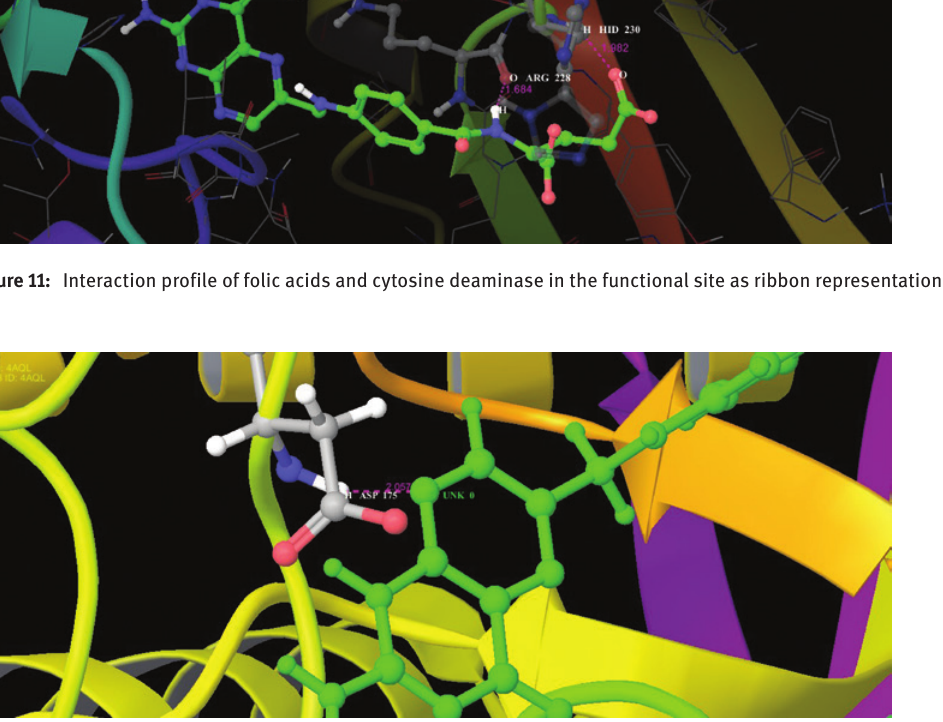
Figure 12: Interaction profile of folic acids and guanine deaminase in the functional site as ribbon